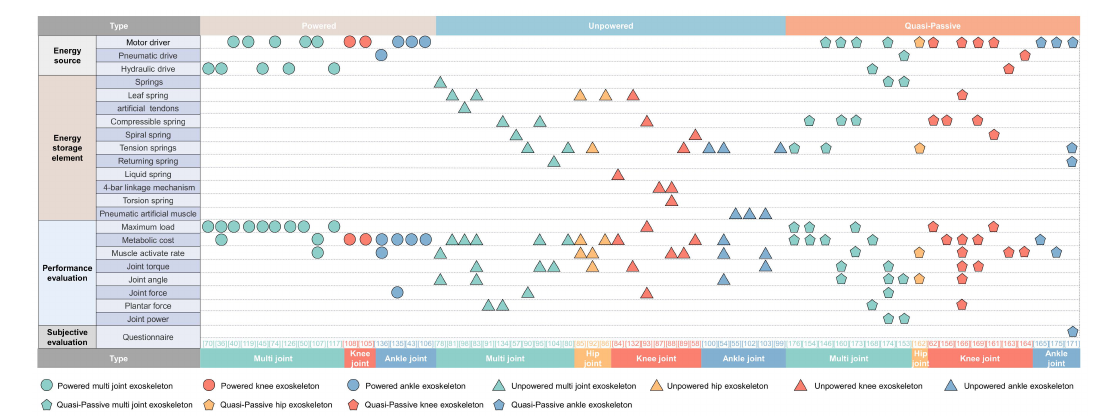
Figure 9. Classification of wearable lower limb assist exoskeleton.